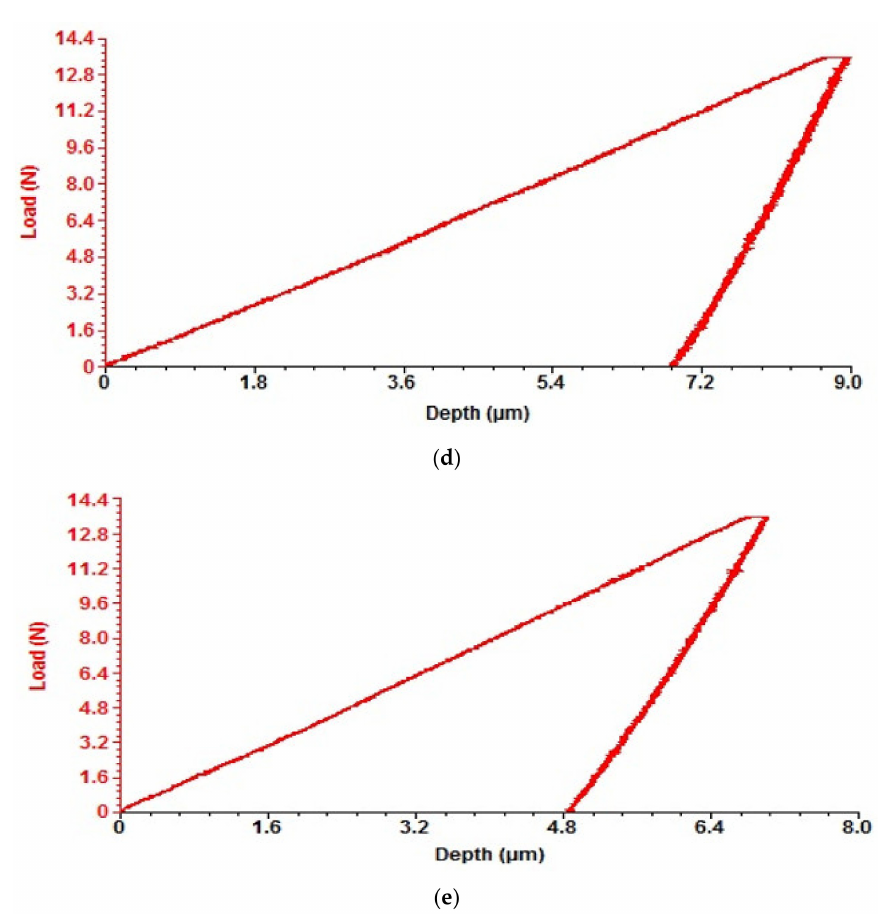
Figure 18. Microindentation tests for non-phosphate nodular cast iron sample. ( a ) Test 1, ( b ) Test 2, ( c ) Test 3, ( d ) Test 4, ( e ) Test